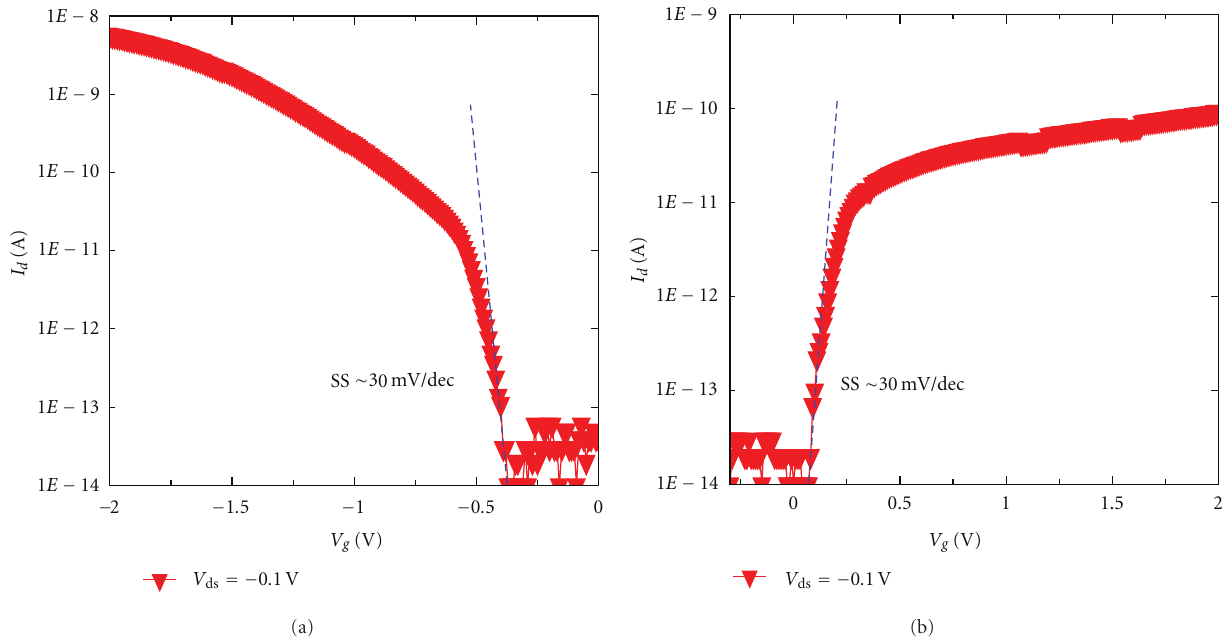
Figure 9: (a) Measured I d - V g characteristics of (a) p-TFET and (b) n-TFET with SS = 30mV/decade averaged over a decade.